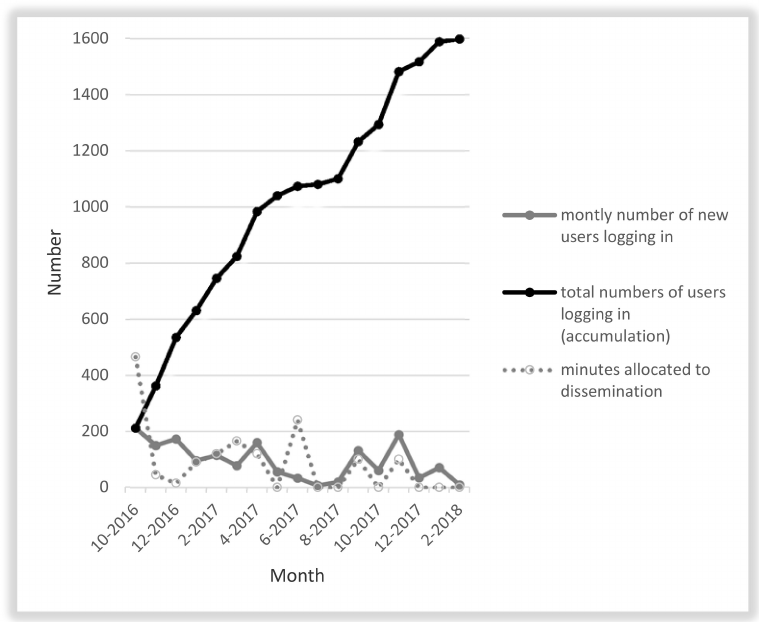
Figure 1. Number of minutes allocated to dissemination and number of visitors logging onto the